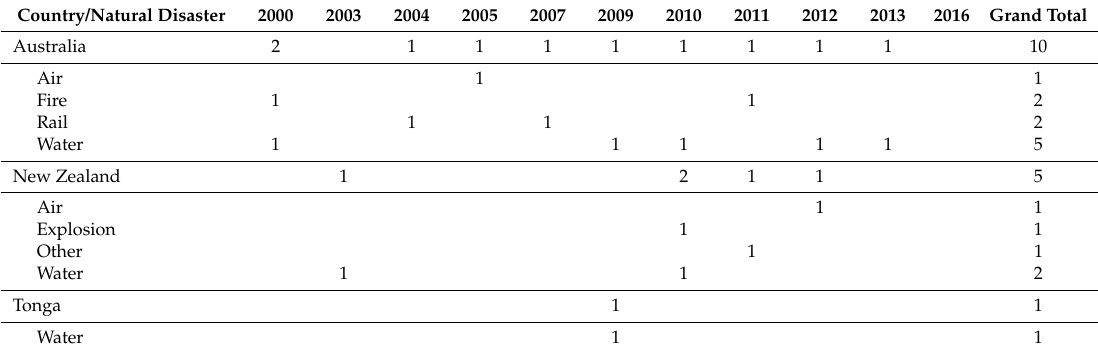
Table 3. Technological disasters in study countries in Oceania 2000–2018 [8]. Country/Natural